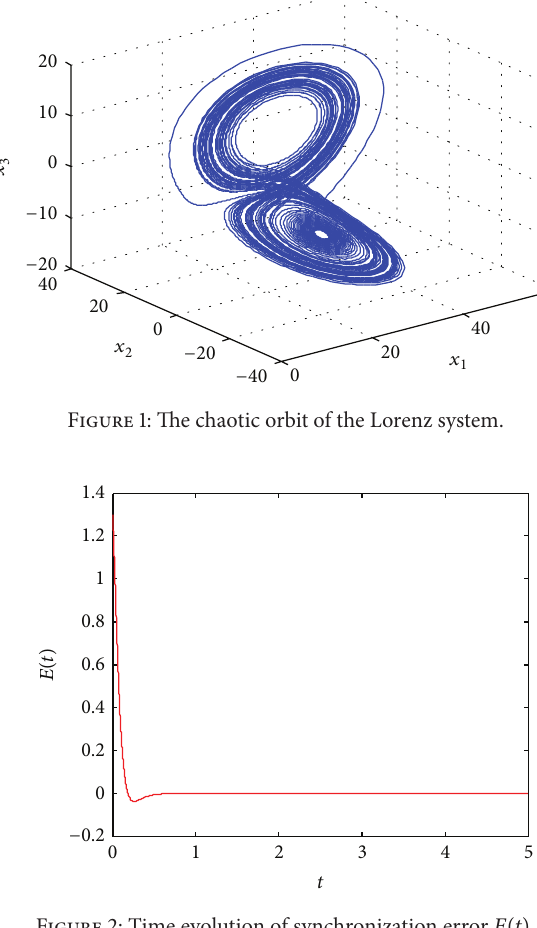
Figure 2: Time evolution of synchronization error 𝐸(𝑡)